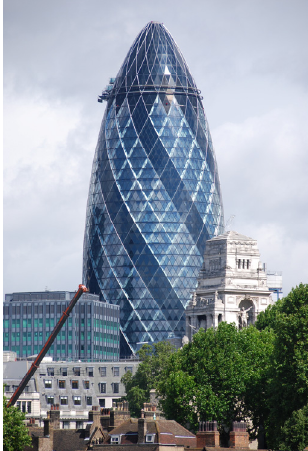
Figure 8. Swiss Re Tower, London, England—Foster and Associates (Courtesy Terri Boake, University of Waterloo).